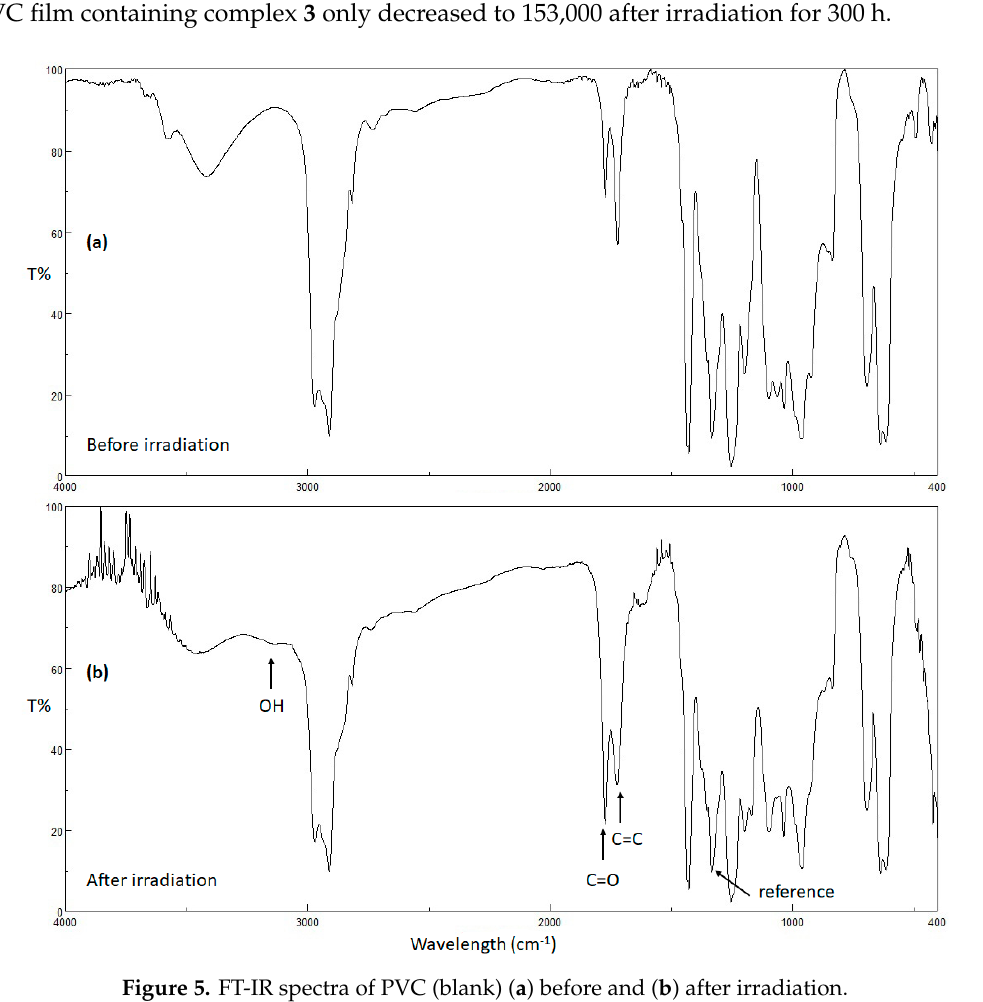
Figure 5. FT-IR spectra of PVC (blank) ( a ) before and ( b ) after irradiation.